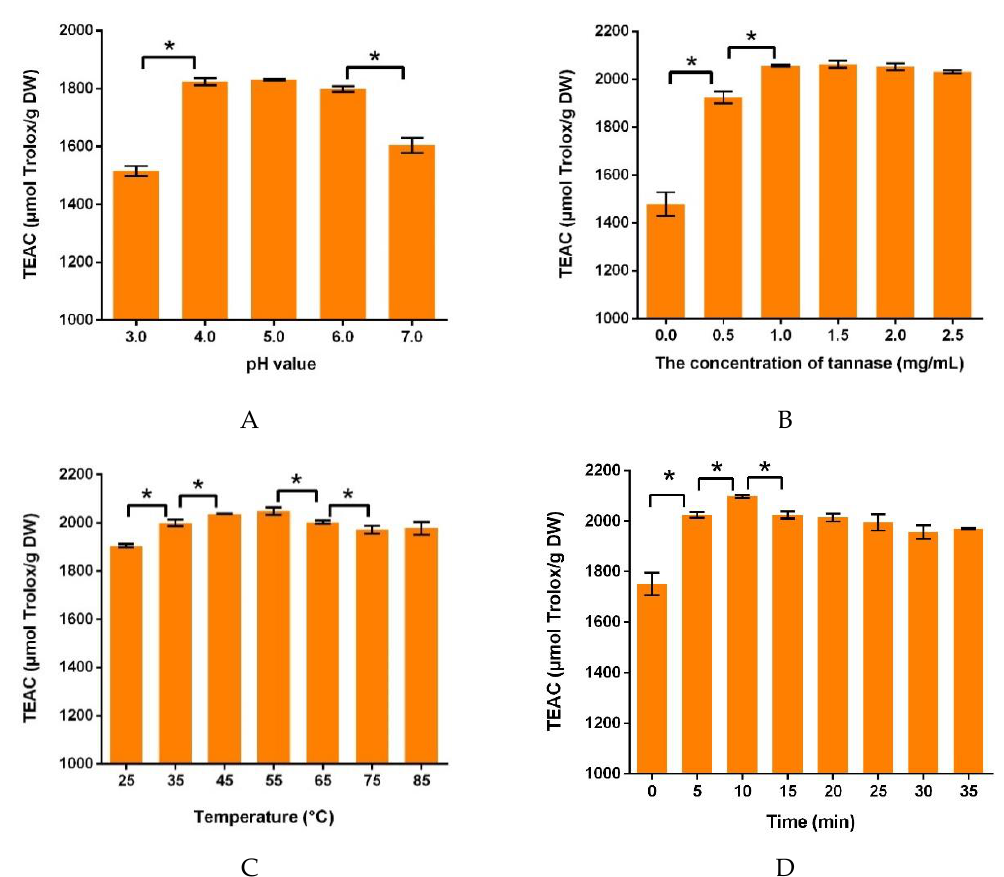
Figure 1. The effects of single factors on the Trolox equivalent antioxidant capacity (TEAC) values. ( A ) the pH value of buffer solution; ( B ) tannase concentration; ( C ) ultrasonic temperature and ( D ) ultrasonic time. DW: dry weight. * Data between groups were significantly different ( p < 0.05).